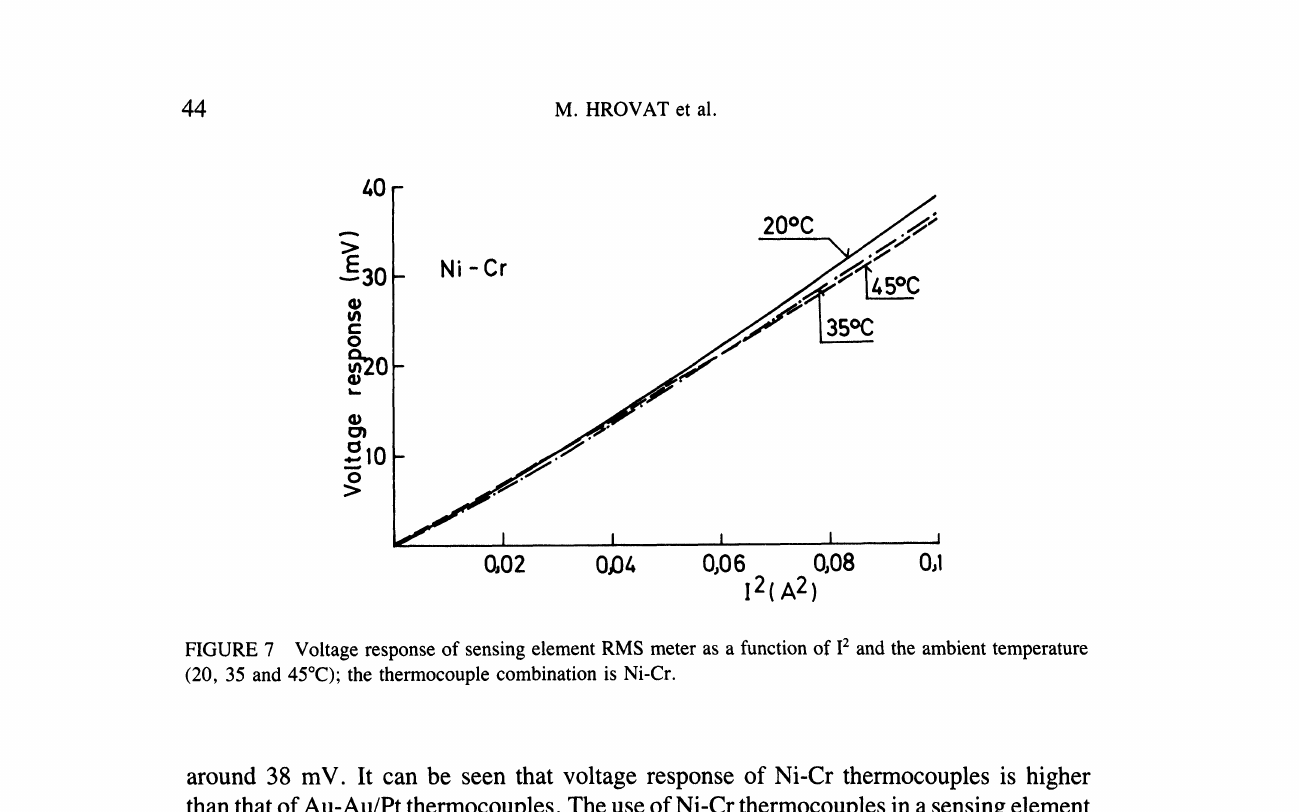
FIGURE 7 Voltage response of sensing element RMS meter as a function of 12 and the ambient temperature (20, 35 and 45C); the thermocouple combination is Ni-Cr.